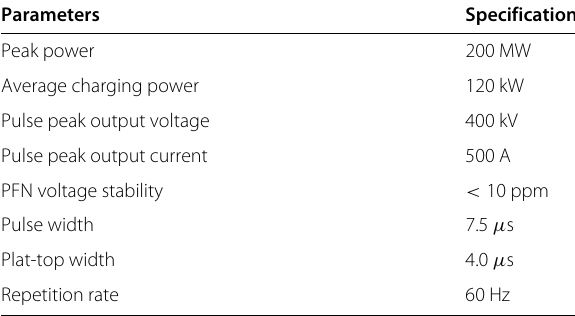
Table 4 Major specifications of the PAL-XFEL modulator Parameters